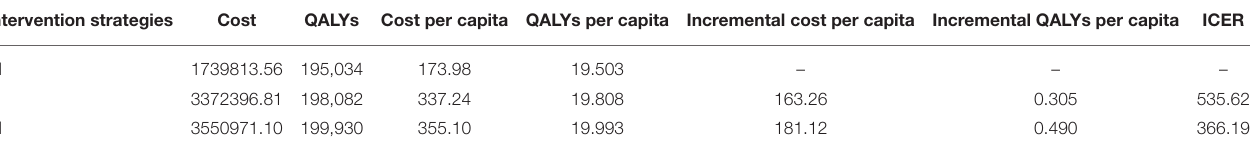
TABLE 4 | Modeled cost-effectiveness ratios based on 10,000 people. Intervention